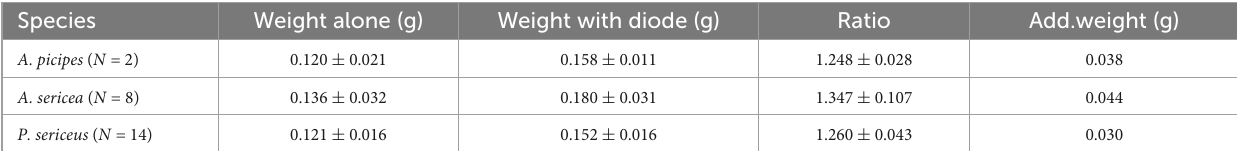
TABLE 1 Species weight alone ( ± SD) and with the diode, and additional weight